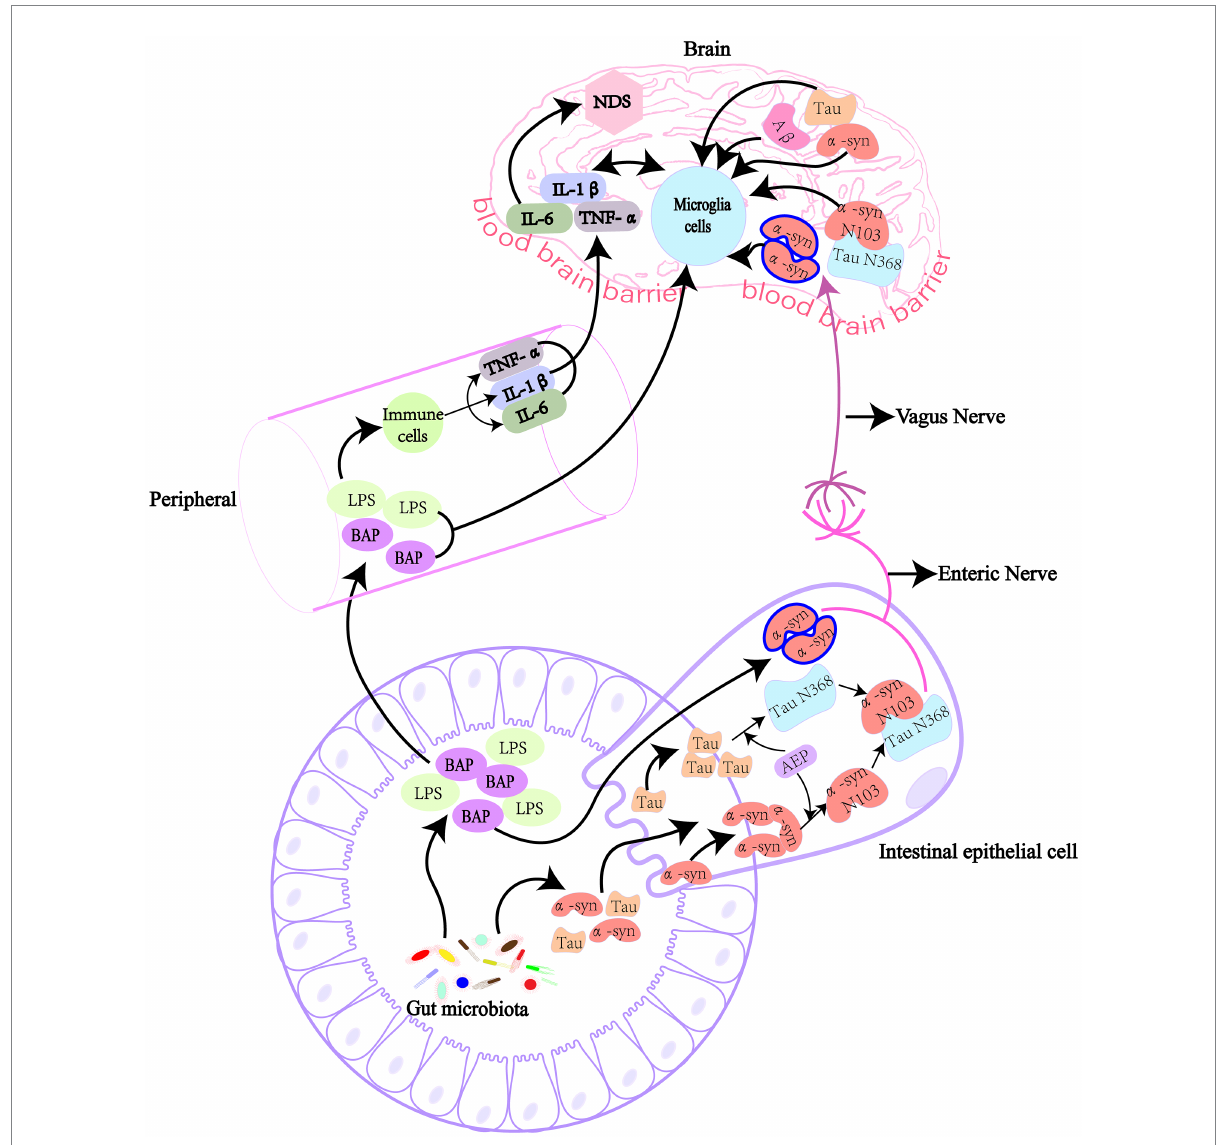
FIGURE 1 GM affect the production of pathogenic proteins in the brain directly and indirectly. GM can produce lipopolysaccharide and amyloid protein, and these harmful substances enter the body and cause NDs when intestinal and blood-brain barriers are damaged. Bacterial amyloid directly cause